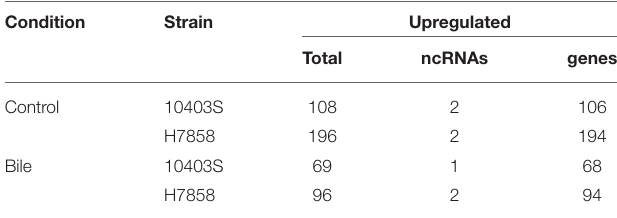
TABLE 5 | Number of transcripts (protein-coding and non-coding) significantly upregulated in the WT vs 1 sigB mutant under control and exposure to bile